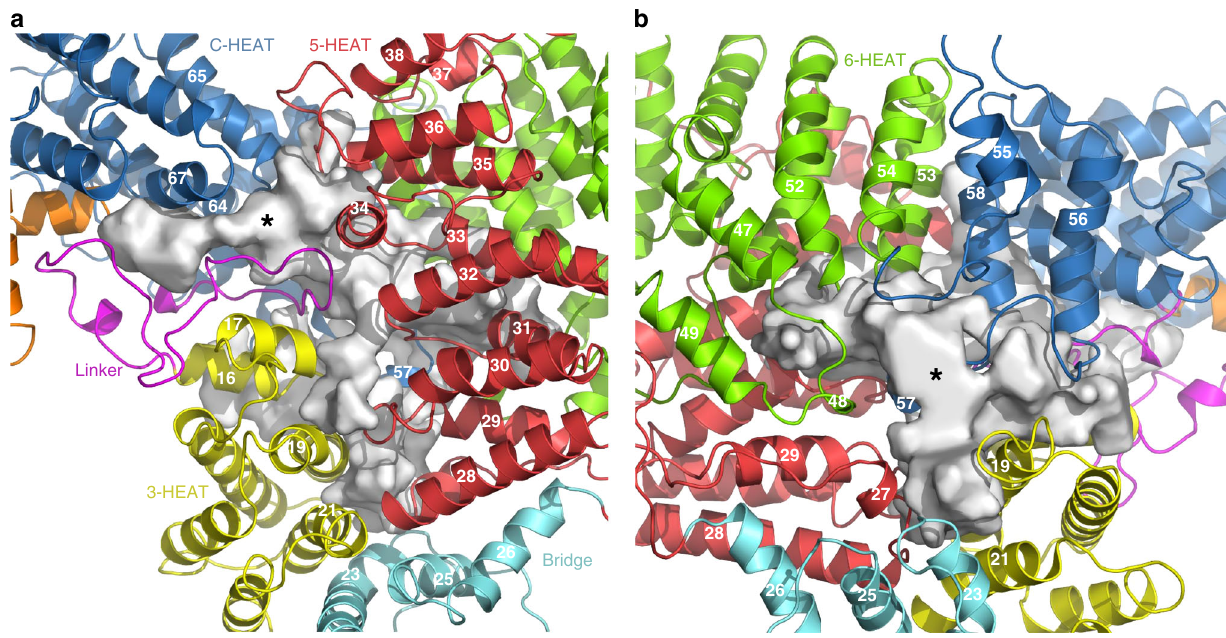
Fig. 3 Illustration of extended grooves in Core MED23. View of the interface on the concave ( a ) and convex ( b ) faces of Core MED23. The linker, 3-HEAT, Bridge, 5-HEAT, 6-HEAT, and C-HEAT are represented in ribbons, following the color code as in Fig. 1. a On the concave face of the MED23 arch, the extended groove running along the surface is illustrated, with the * pointing to the opening of the cavity. b On the convex face of the arch, 6-HEAT and C- HEAT stack against 3-HEAT and 5-HEAT, de fi ning a funnel-shaped groove. Here also the * represents the opening of the cavity. Helices contributing to